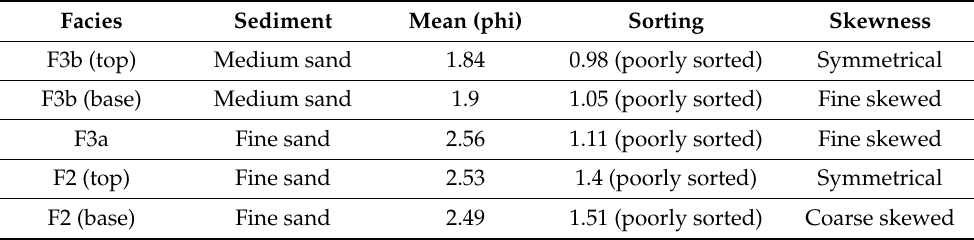
Table 1. Core GB: grain-size